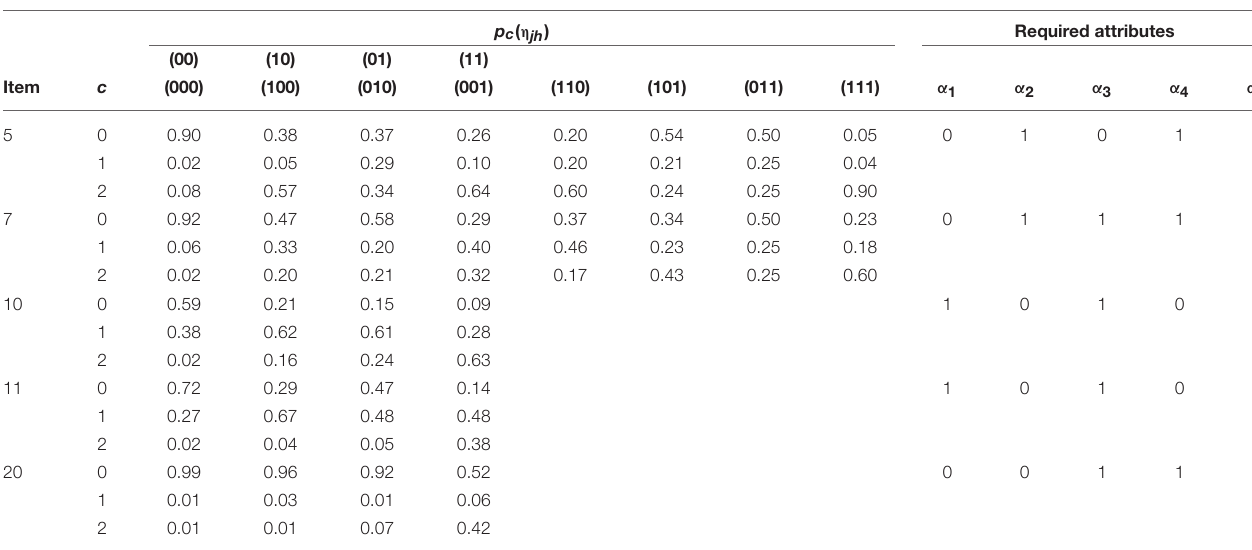
TABLE 6 | Estimates of conditional probabilities for polytomous items.